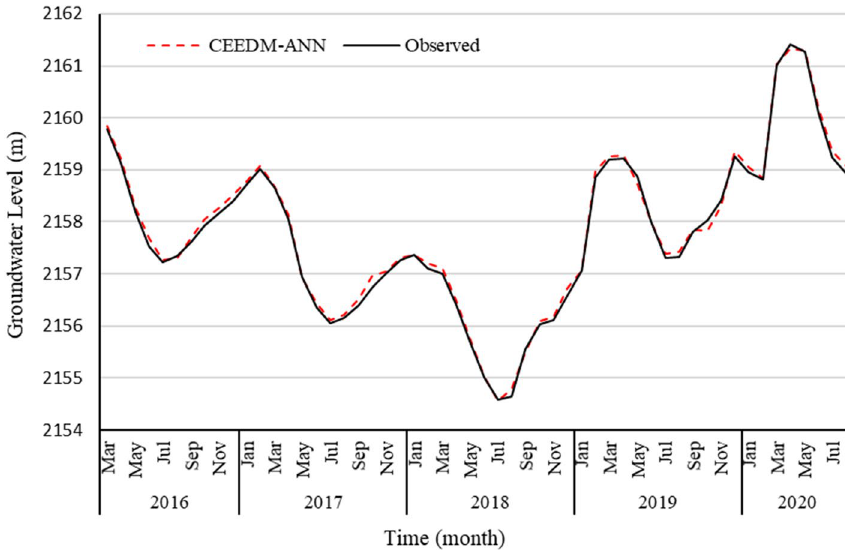
Fig. 11 Comparison of the CEEMD-ANN model with observed data